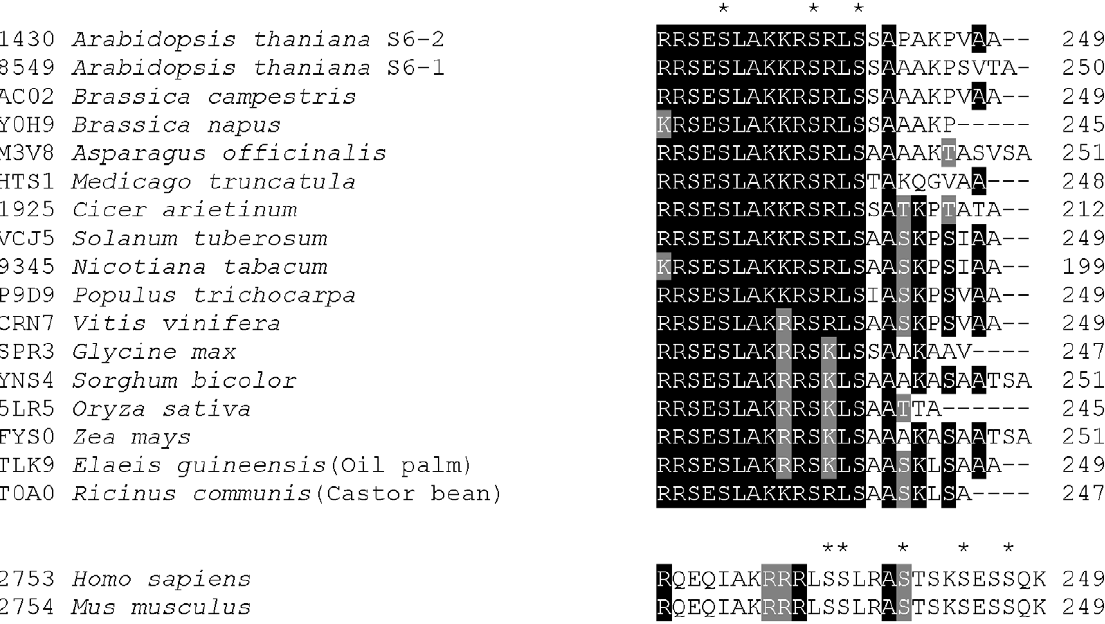
Figure 5. Conservation of three phosphorylated serine residues in C-termini of the 40S ribosomal proteins S6 from higher plants. Alignment of C-terminal sequences from the 40S ribosomal proteins S6 of higher plants. UniProt accession numbers, organism names and numbers of the last amino acids in corresponding protein sequences are indicated. Positions of three serine residues found phosphorylated in S6-1 and S6-2 proteins from Arabidopsis thaliana are indicated by asterisks. Below the alignment the two identical C-terminal sequences from the 40S ribosomal proteins S6 of Homo sapiens and Mus musculus are shown. Positions of five conserved serine residues phosphorylated in animal S6 proteins are indicated by